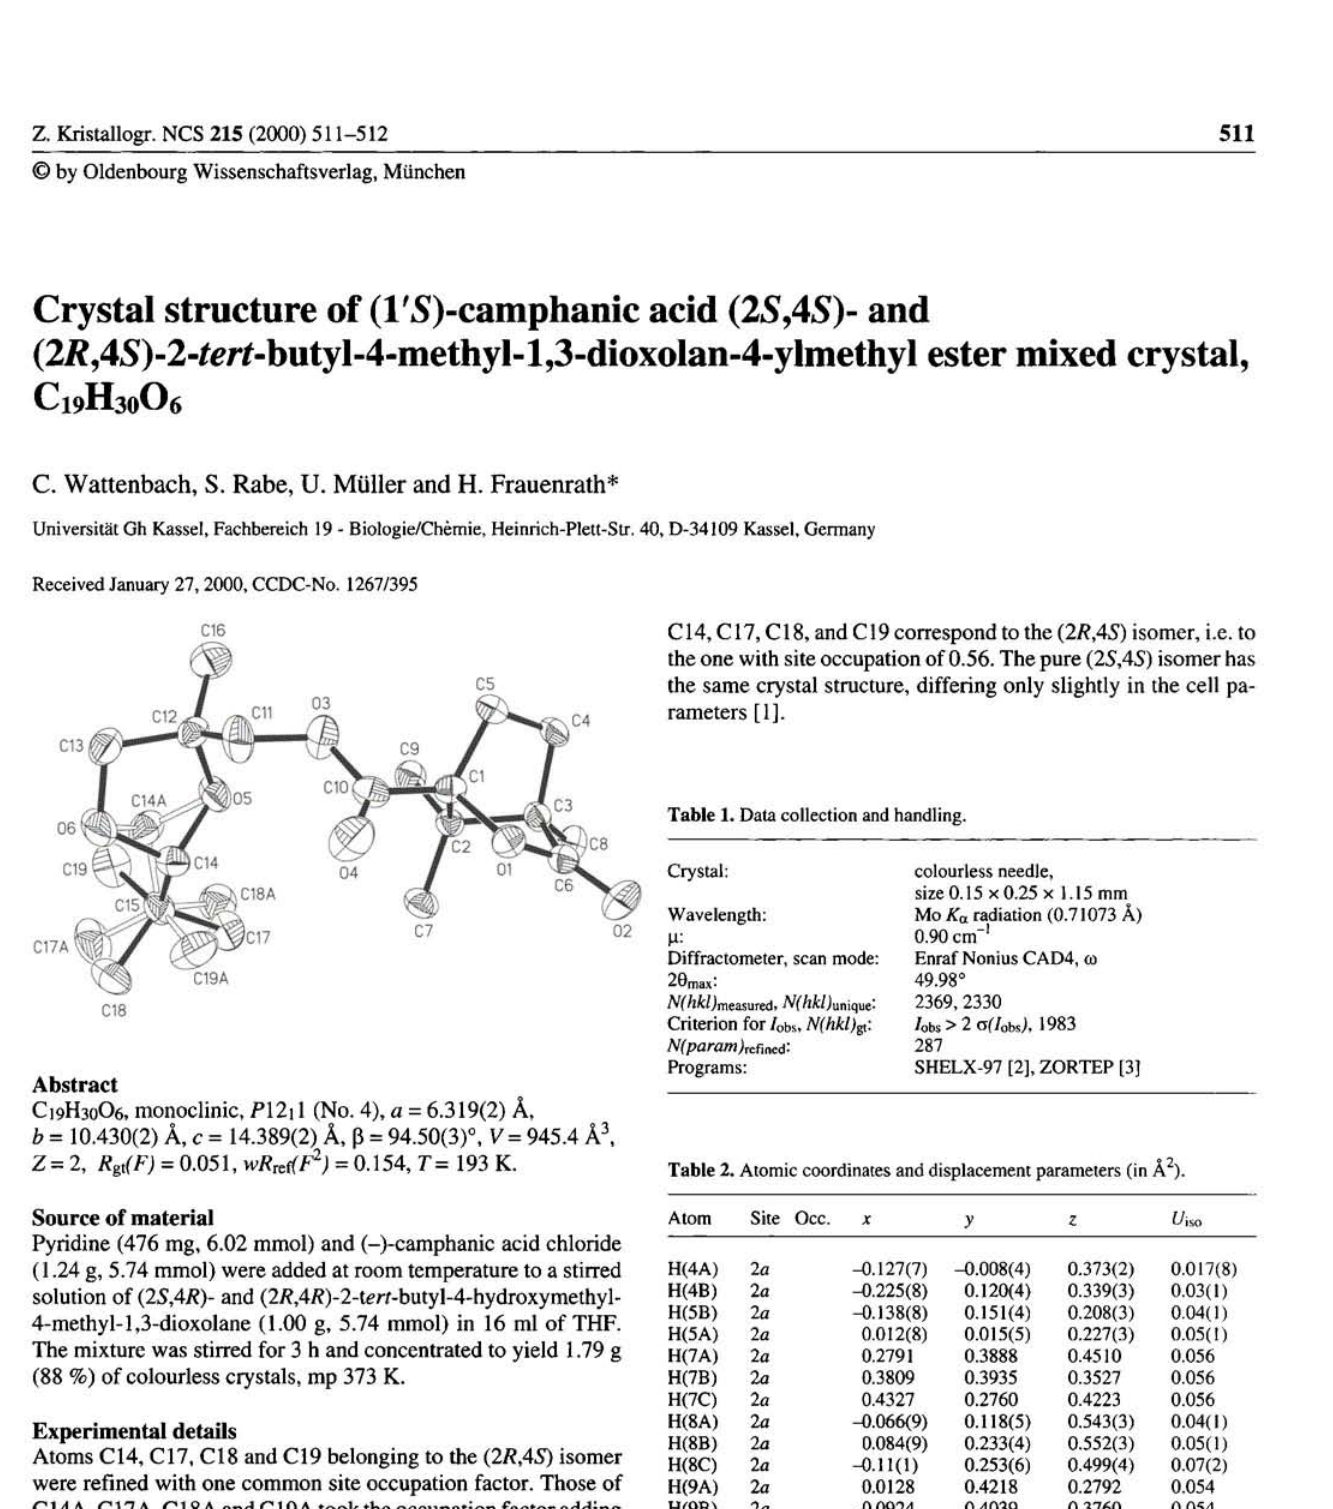
Table 2. Atomic coordinates and displacement parameters (in Â 2